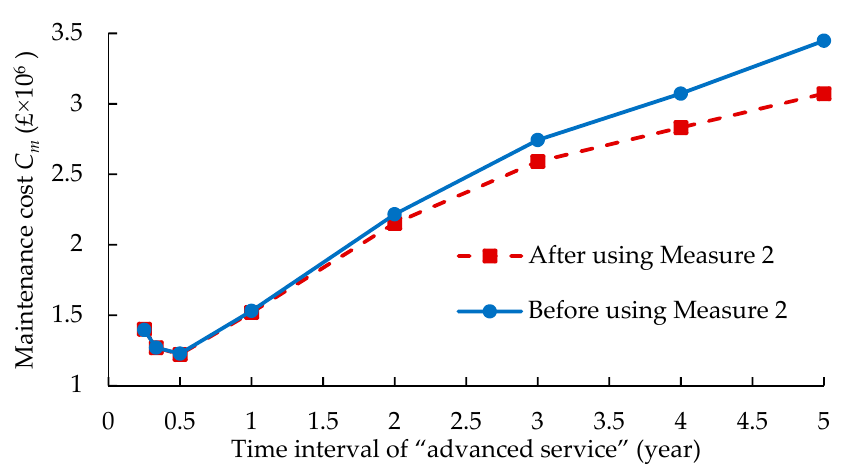
Figure 11. Maintenance costs versus the time interval of “advanced service”. From Figure 11, it is found